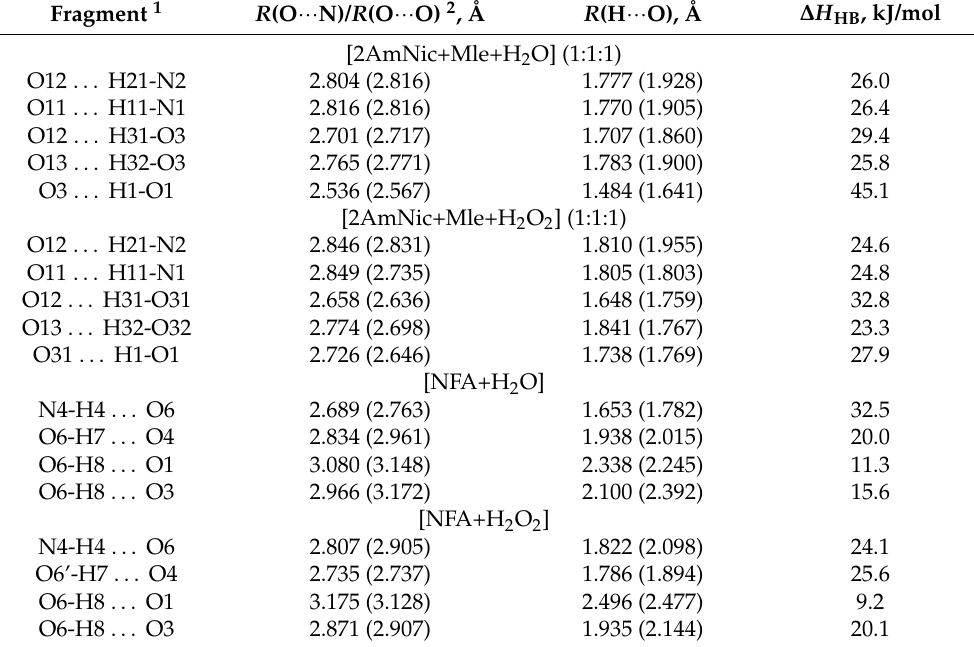
Table 1. Distances between the atoms involved in the formation of intermolecular H-bonds in [2AmNic+Mle+H 2 O], [2AmNic+Mle+H 2 O 2 ], [NFA+H 2 O] and [NFA+H 2 O 2 ]; R (O ··· N), R (O ··· O), and R (H ··· O) obtained using periodic DFT computations (PBE-D3/6-31G**) and the ∆ H HB values evaluated using Equation (1). Fragment